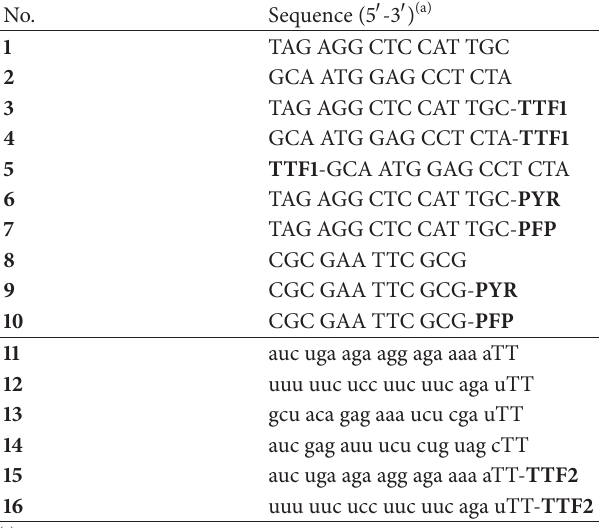
Table 1: Sequences of DNA and RNA